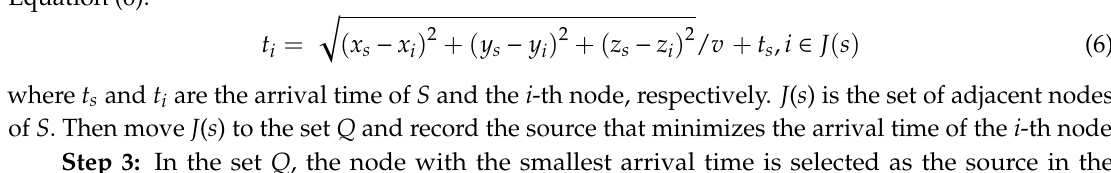
Figure 5. The process of judging whether node A and node B are adjacent nodes.